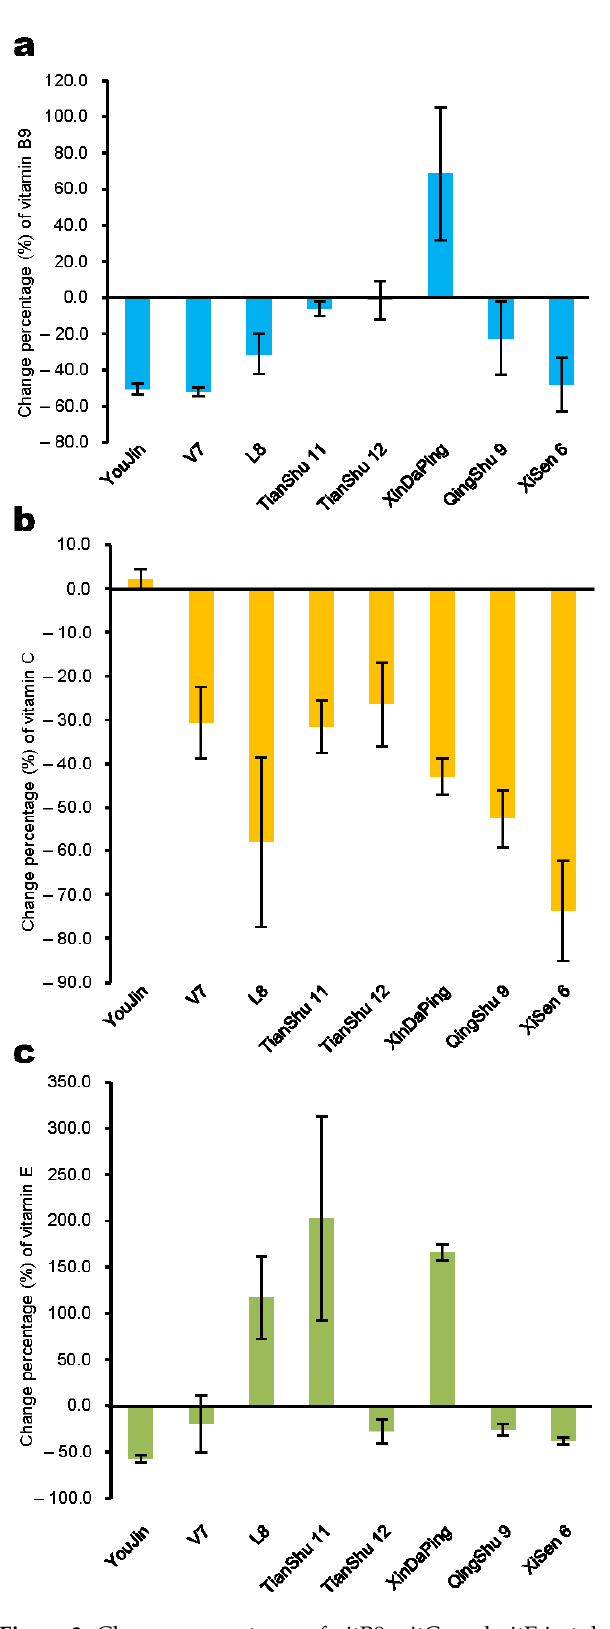
Figure 3. Change percentages of vitB9, vitC, and vitE in tubers of potato cultivars after steaming, respectively. ( a ) Change percentage of vitB9; ( b ) change percentage of vitC; ( c ) change percentage of vitE.